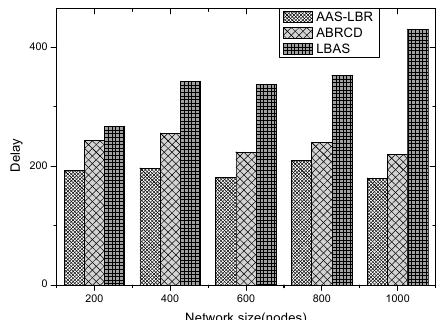
Figure 45. The impact of network size with fixed value of | T | = 90 on the broadcast delay.